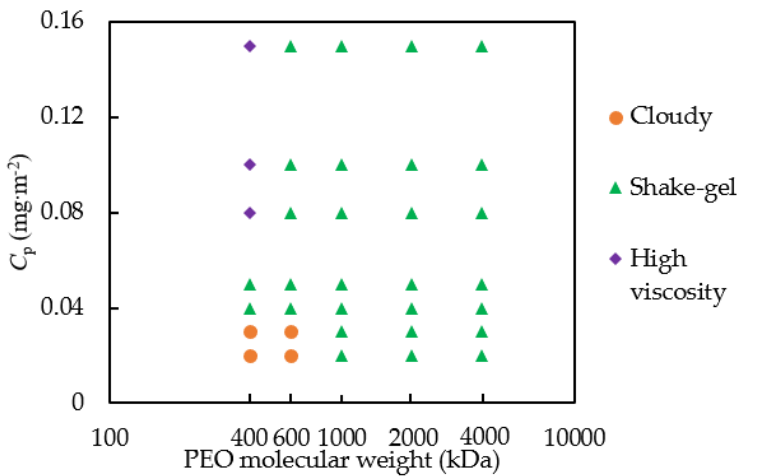
Figure 1. The state diagram of the silica-PEO suspension. The silica concentration was fixed to 20 wt%; the PEO molecular weight was changed to 400, 600, 1000, 2000, and 4000 kDa; and the pH was 9.4. C p is the PEO dose per silica surface area.